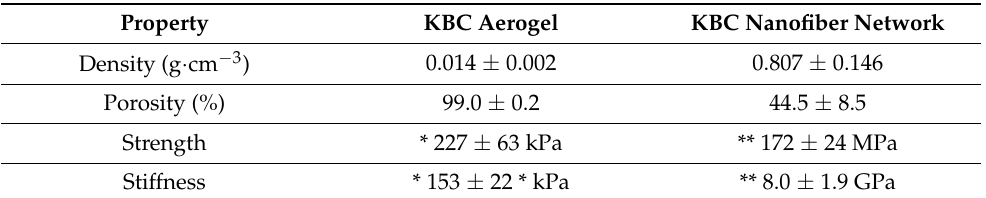
Table 1. Physical and mechanical properties of the KBC aerogels and KBC nanofiber network (* compression test; ** tensile test).